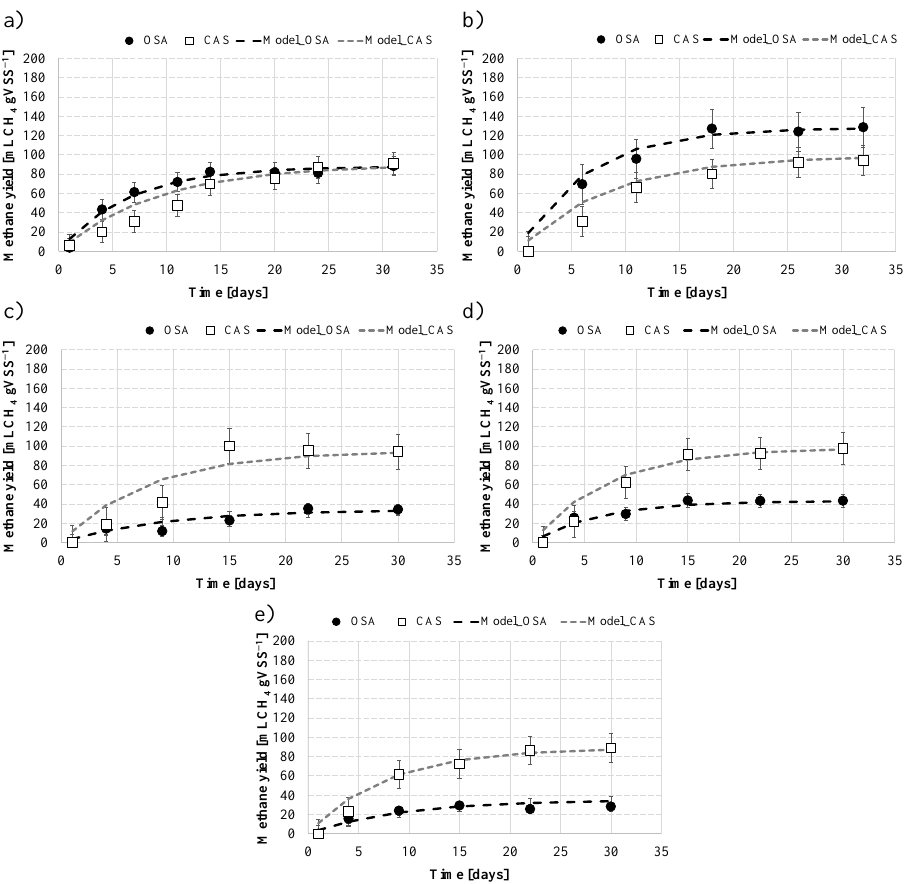
Figure 3. ( a – e ) Cumulative methane production obtained from the excess sludge of OSA and CAS plants, in Periods 1–5 (bars indicate standard deviation).